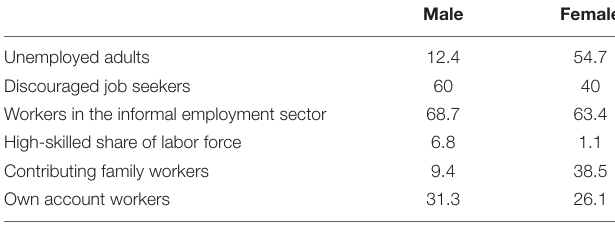
TABLE 1 | Selected contextual data on Yemen.